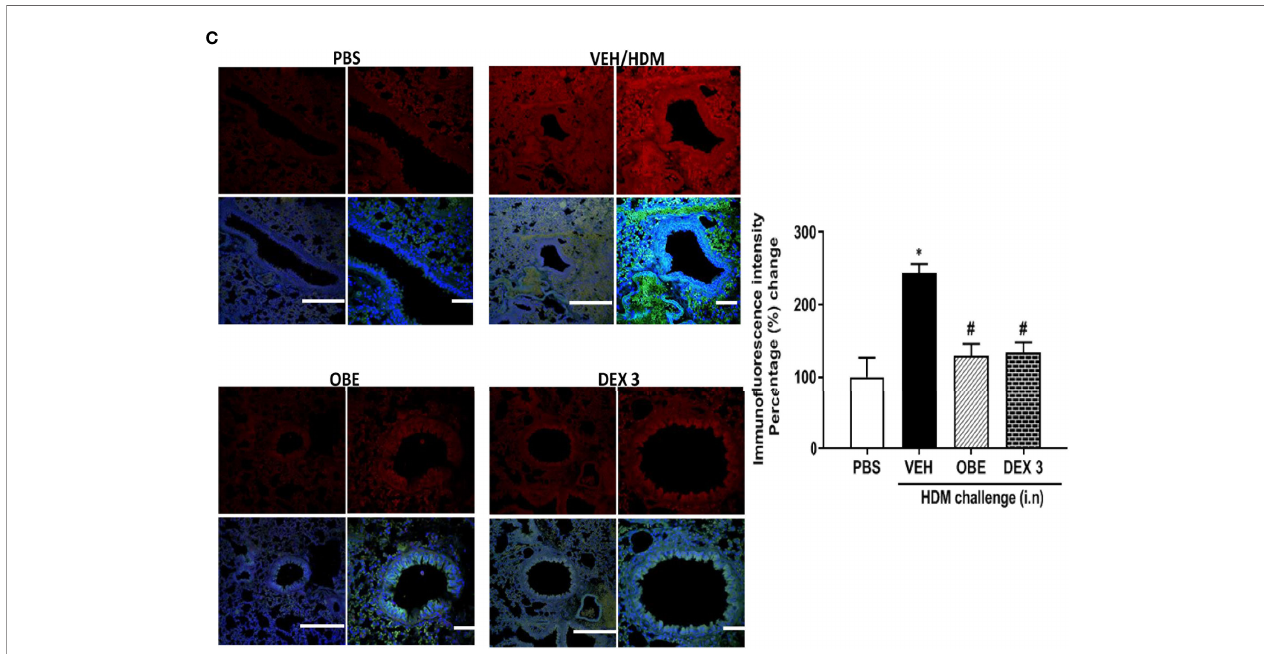
FIGURES 5 | Immuno fl uorescent (Alexa Fluor) detection of pEGFR (A) pERK1/2 (B) and pAKT (C) shown in the upper panels overlaid with DAPI stain on the lower panel to show lung tissue architecture. Lung sections were taken from different treatment groups: PBS-challenged mice (PBS), HDM-challenged mice pretreated with vehicle (HDM), HDM-challenged mice pretreated with OBE (60 mg/kg; i.p.) (OBE), and HDM-challenged mice pretreated with dexamethasone (DEX) and immunostained for pEGFR, pERK, and pAKT. PBS-treated mice showed minimal pEGFR, pERK1/2, and pAKT expression. HDM challenge resulted in a signi fi cant increase in pEGFR, pERK, and pAKT expression, and this was inhibited following treatment with OBE (60 mg/kg; i.p.) and was comparable to the dexamethasone- treated animals, scale bar = 50 µm. Graphs show quantitative assessment of fl uorescence intensity of pEGFR, pERK1/2, and pAKT (arbitrary units). Data are expressed as mean ± SEM ( n = 3 – 5). *P < 0.05 vs PBS group, # P < 0.05 vs HDM